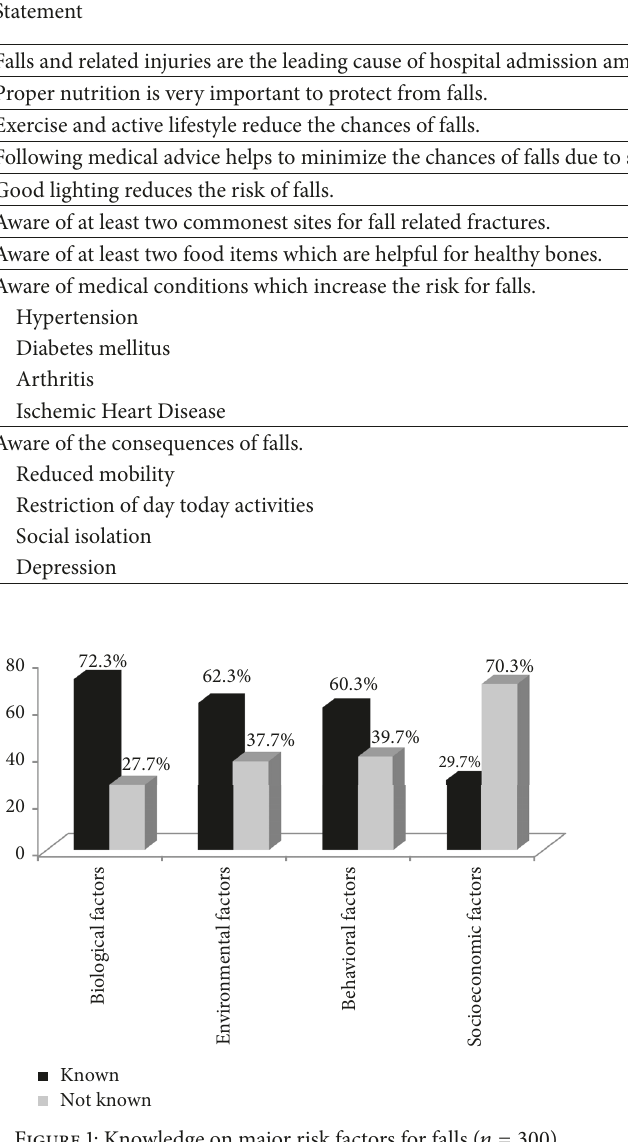
Figure 1: Knowledge on major risk factors for falls ( 𝑛 = 300